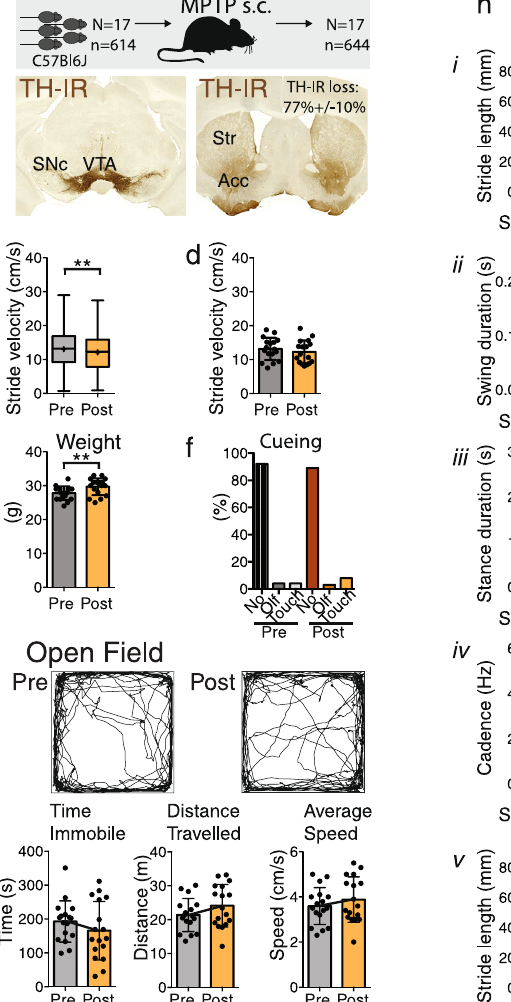
Model 1: MPTP model. Following subcutaneous MPTP treatment, densitometry of tyrosine hydroxylase in the striatum showed an average bilateral reduction of 77% + / − 10% as compared to an untreated control cohort (n = 8) post-hoc (Fig. 3). Four weeks after MPTP treatment (dataset 17; Supplementary Table S1), veloc- ity was decreased compared to baseline (dataset 16; Supplementary Table S1), though only significantly for stride-to-stride data (Fig. 3c,d). Regression analysis of pre-lesion versus post-lesion datasets from the same ani- mals (Fig. 3h; Supplementary Table S3) showed a downward shift of the curve representing stride length, mean- ing stride length was shorter than expected for a given speed. Other parameters were also affected: the curve for swing duration shifted downward, stance duration shifted to the left and cadence increased. Conventional